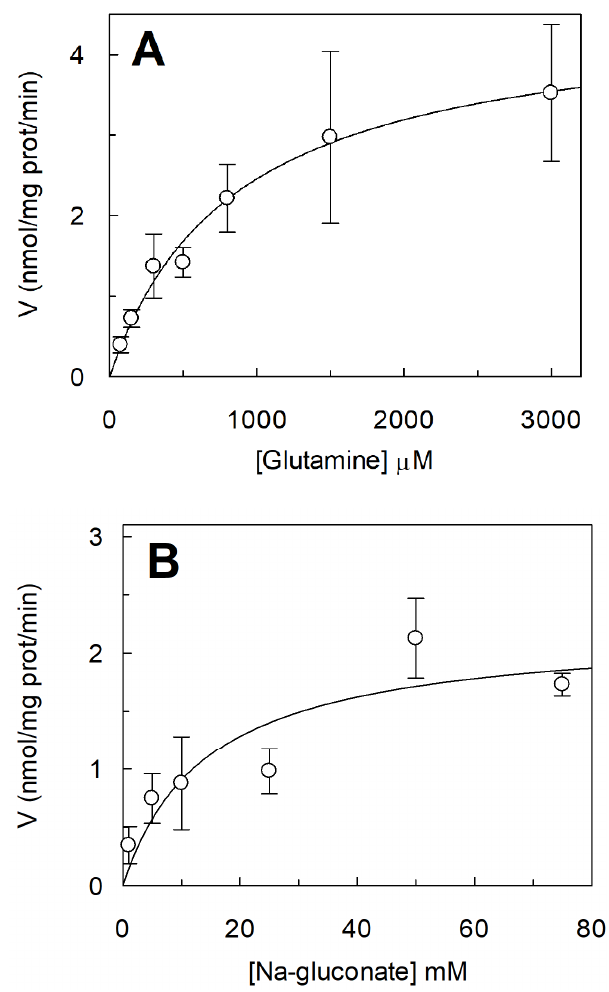
Figure 5. Kinetic analysis of [ 3 H]-glutamine unidirectional transport by C467A reconstituted in proteoliposomes. In ( A ), dependence of the transport rate of C467A reconstituted in proteolipo- somes on external [ 3 H]-glutamine. The reconstitution was performed as described in Materials and Methods. The transport rate was measured by adding indicated [ 3 H]-glutamine concentrations to proteoliposomes in the presence of 50 mM Na-gluconate. In ( B ), dependence of the transport rate of C467A reconstituted in proteoliposomes on external Na + -gluconate. The reconstitution was performed as described in Materials and Methods. The transport rate was measured by adding indicated Na-gluconate concentrations to proteoliposomes in the presence of 500 µ M [ 3 H]-glutamine. In ( A , B ), data were plotted according to Michaelis–Menten equation and results are means ± S.D. of three independent